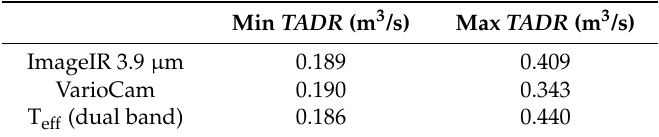
Table 5. TADR based on the observations with thermal cameras on 20 September 2014 at 7:39:39